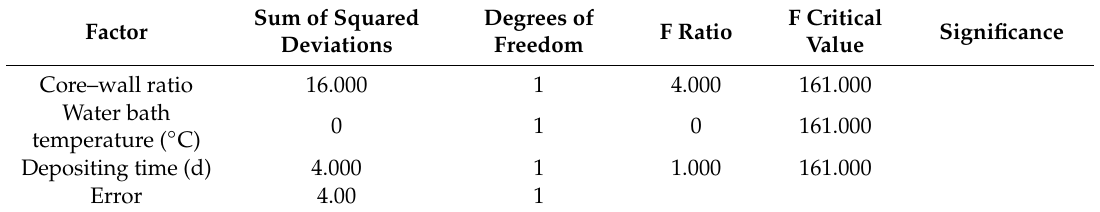
Table 6. Variance results of microcapsule encapsulation